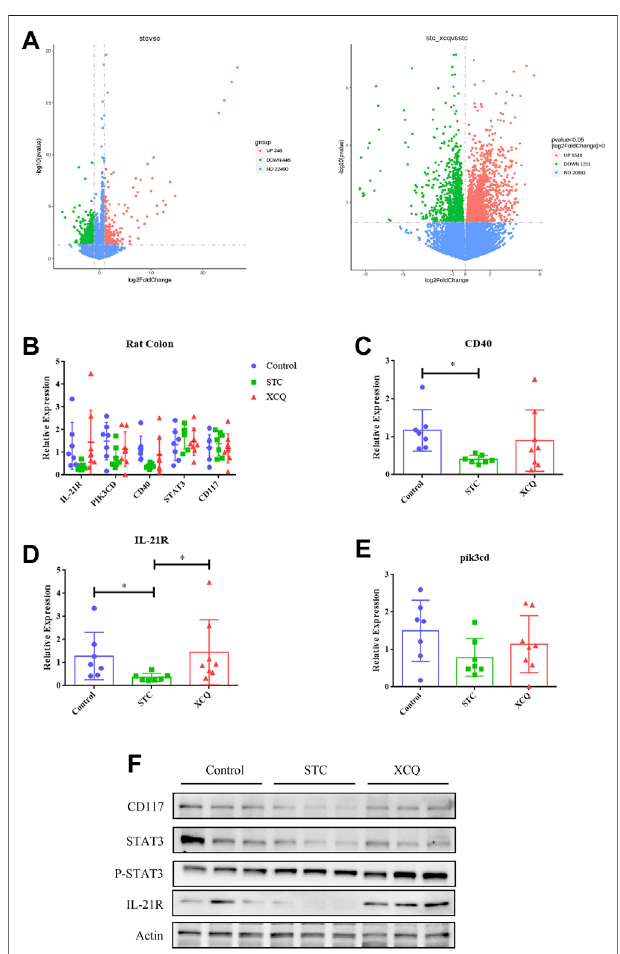
FIGURE 5 | The effect of the Xiao Chengqi formula on slow transit constipation(STC)ratsatthecolonictranscriptomelevel. (A) Geneexpression among the three groups: STC group versus the control group (left) and experimental group versus the control group (right), the descending gene (green), ascending gene (red) and no signi fi cant difference gene (blue); (B) the expression of IL-21R, CD40, and pik3cd was signi fi cantly different among the three groups, * p < 0.05; (C – E) The protein expression levels of CD117, IL-21R and their downstream STAT3 activation between groups; (F) the expression of CD117, IL-21 and its downstream STAT3 activation in rat